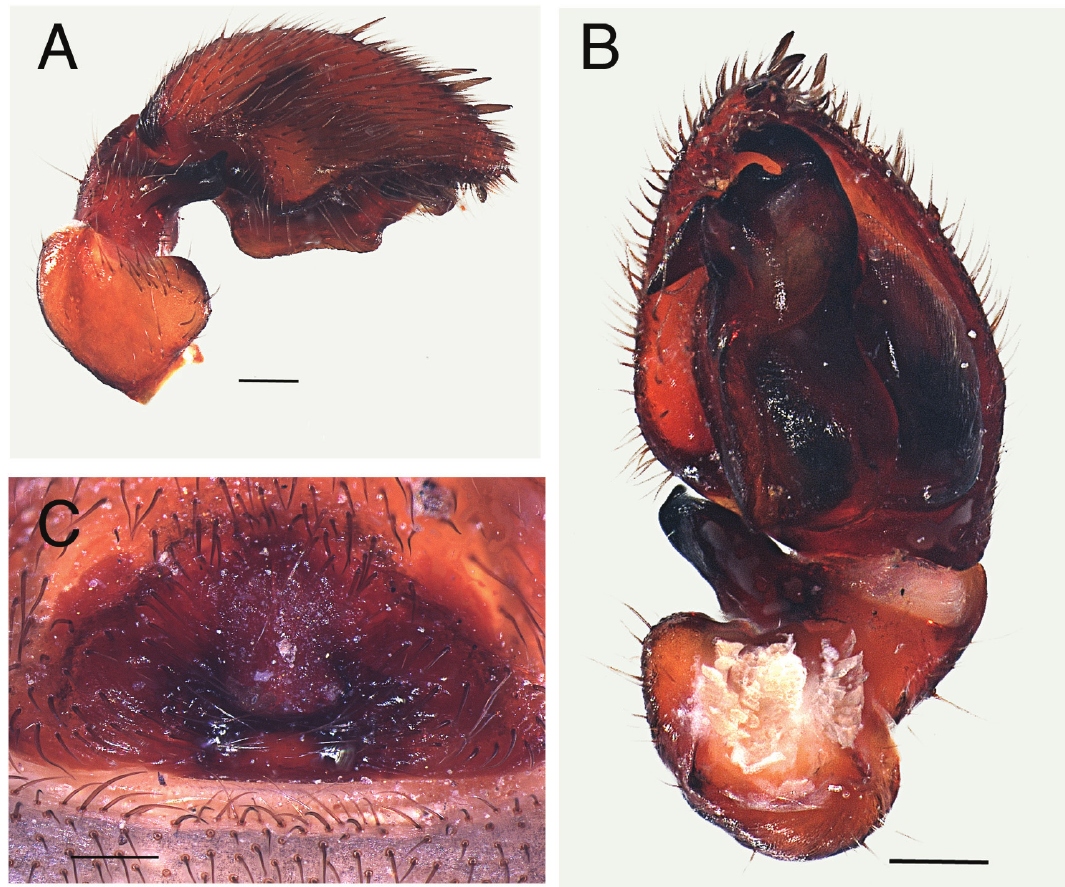
Fig. 9. Palindroma avonova gen. et sp. nov. A–B. Holotype, ♂. C. ♀ from Maringa Forest. A . ♂, palp, retrolateral view. B . Idem, ventral view. C . ♀, epigyne, ventral view. Scale bars = 0.2